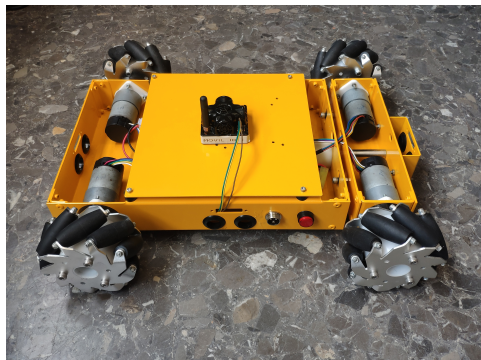
Figure 11. Real robot.